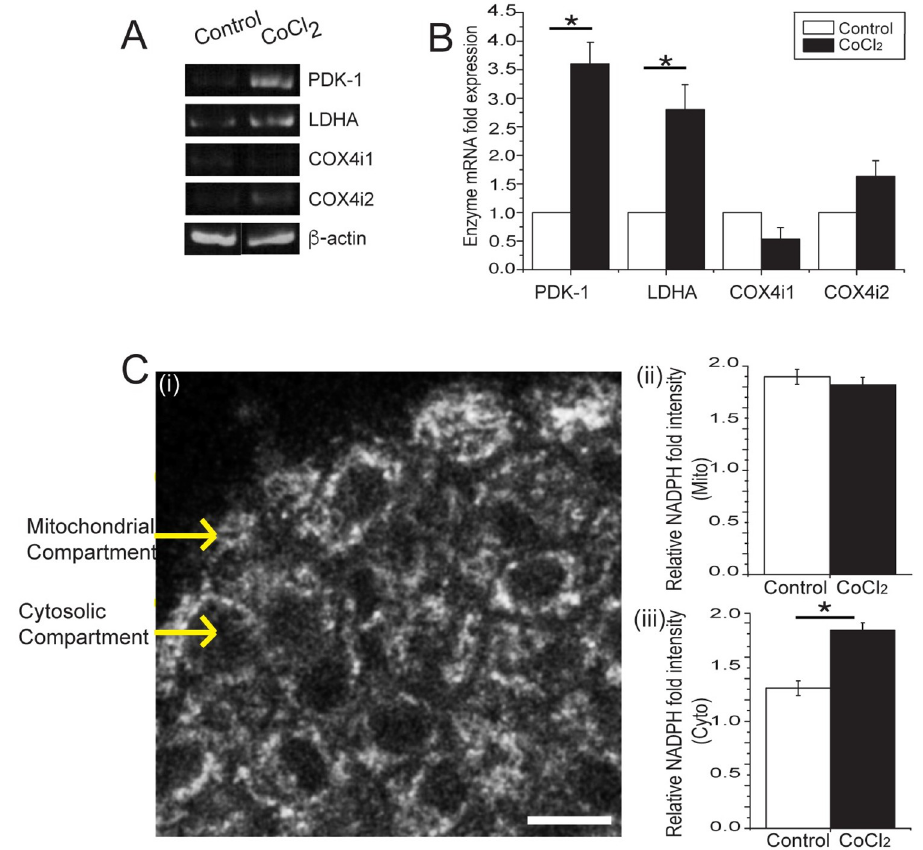
Fig 2. Effect of CoCl 2 on islet beta-cells. Islets isolated from C57Bl6 mice were cultured in the absence (0 μ M) and presence (100 μ M) CoCl 2 for 24 hrs. (A) RNA was extracted from islets and RT-PCR was run to determine the presence of metabolic enzymes (PDK-1, LDHA, COX4i-1 & COX4i-2) compared to the house-keeping gene β -actin (n = 10 mice on separate days). (B) Bar graph shows the quantification of RNA results from (A) . mRNA fold expression of metabolic enzymes. White bars represent control (0 μ M CoCl 2 ) islets; black bars represent CoCl 2 (100 μ M) treated islets. (C)(i) High-resolution NADP(H) image of an islet using two-photon microscopy. Yellow arrows point to the mitochondrial and cytoplasmic compartments (scale bar = 15 μ m). (C)(ii) Bar graphs show the relative NAD(P)H intensity in the mitochondrial compartment (Bar graph at top) and (C)(iii) in the cytoplasmic compartment (Bar graph at bottom). White bars represent control (0 μ M CoCl 2 ) islets; black bars represent CoCl 2 (100 μ M) treated islets (n = 10 mice on separate days). Error bars are ± SEM. � p < 0.05. All images were identically Gaussian filtered and stretched for visualization